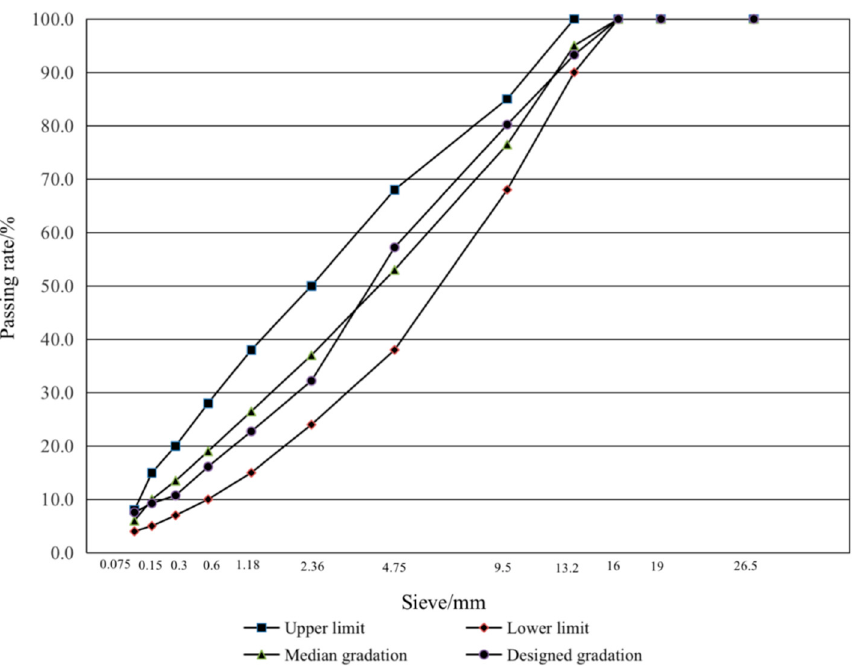
Figure 2. Synthesis gradation curve of AC ‐ 13.